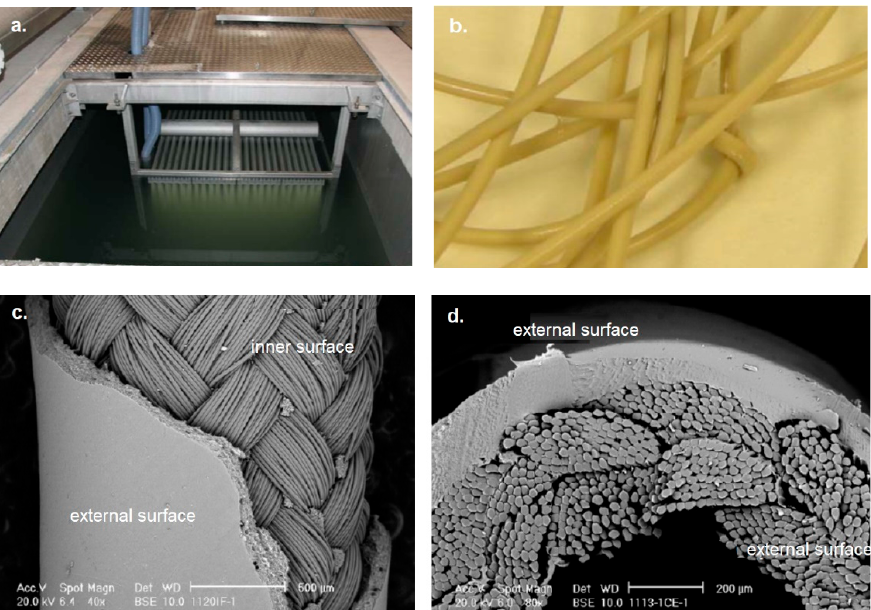
Figure 2. Detail of hollow fiber membrane: ( a ) frame with hollow membrane modules, ( b ) hollow membrane filament, ( c ) lateral image of the inner and external surface of a hollow fiber, and ( d ) frontal image of the inner and external surface of a hollow fiber. WWTP B was designed to treat a flow of 9000 m 3 /day, with the aim of serving a population equivalent to 36,000 equivalent inhabitants. This WWTP has a biological treatment of activated sludge and an MBR system, using Kubota ES200 flat membranes made of chlorinated polyethylene and with a nominal pore size of 0.4 microns maximum (average of 0.2 microns). The ultrafiltration process has 5 treatment lines, consisting of 20 modules of 200 membranes per module. Figure 3a–d show the details of a flat membrane.